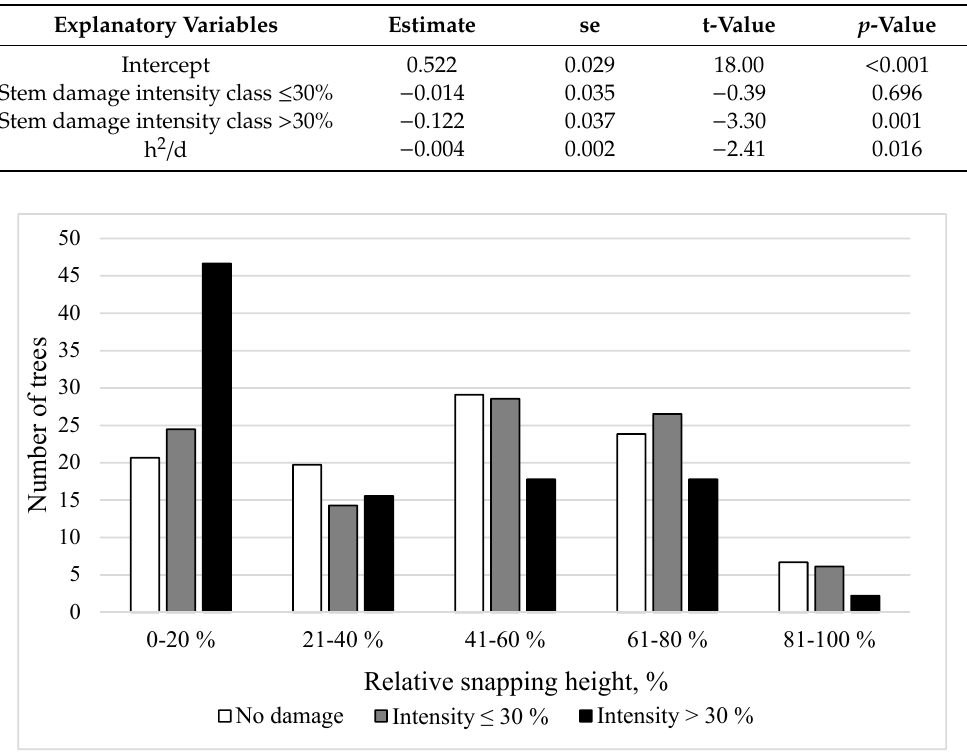
Figure 4. The percentage of trees by relative snapping height (%) in different stem damage intensity classes (the relative damaged area of stem circumference) .